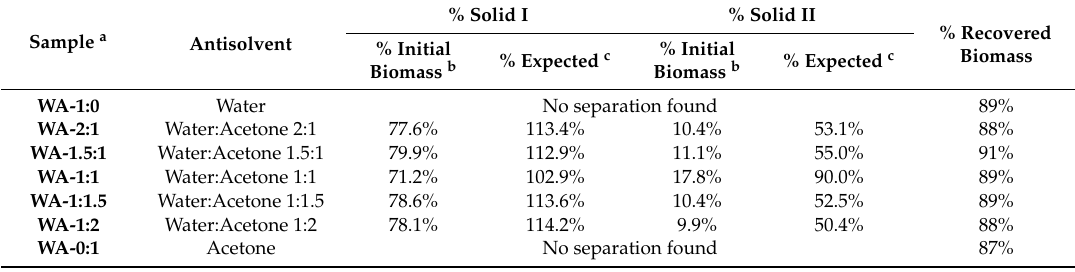
Table 2. Mass balance of matter based on dry barley straw after precipitating the biomass with di ff erent water:acetone antisolvent mixtures. The barley straw samples were dissolved in [EMIMAcO]) at 105 ◦ C for 3.5